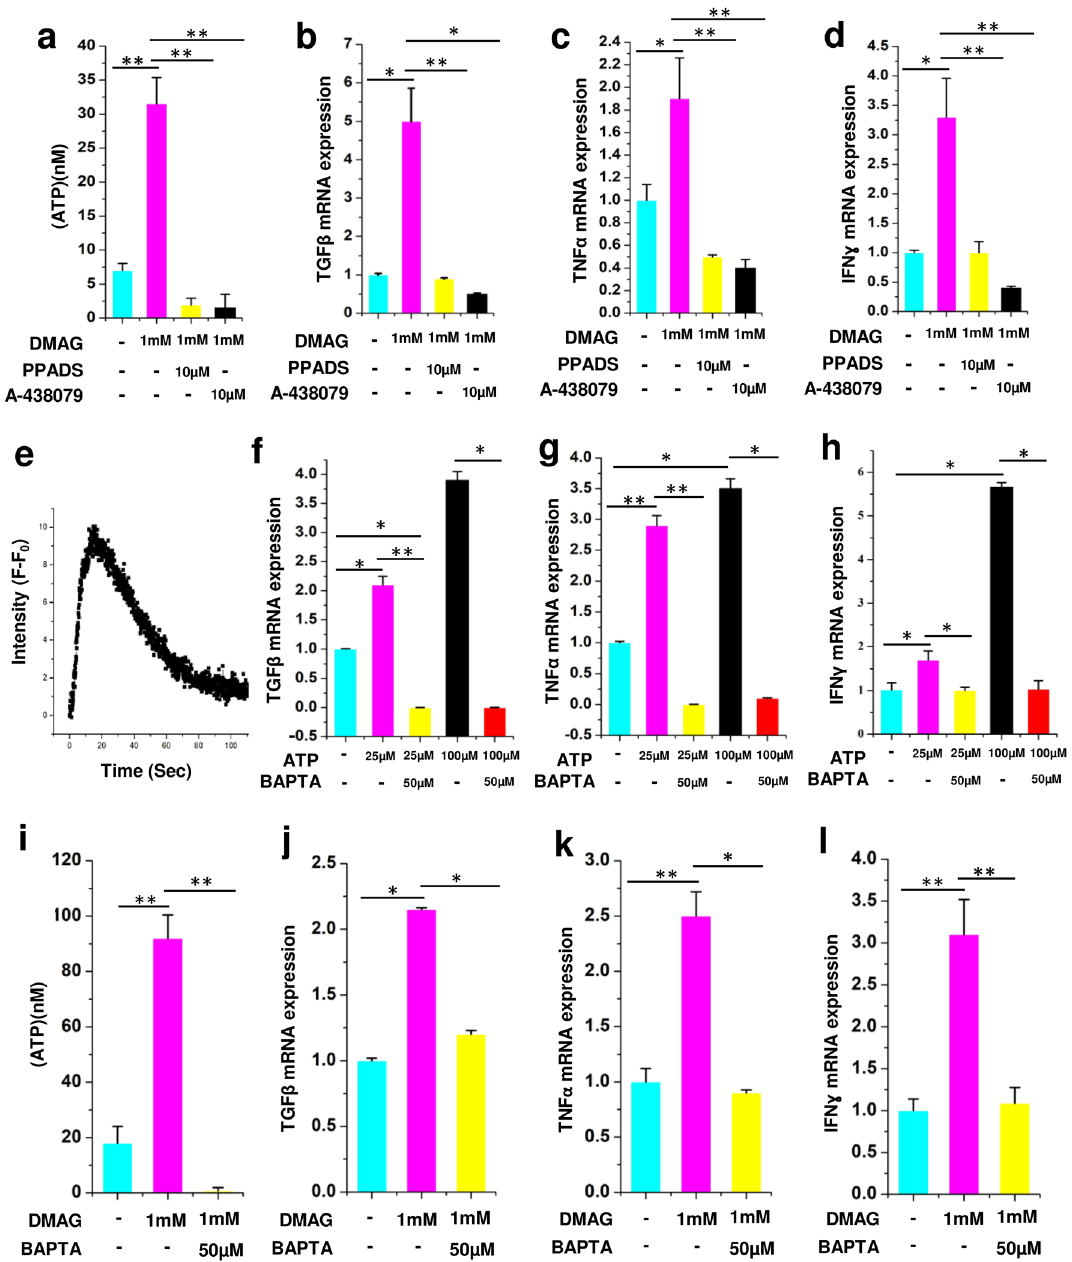
Figure 4. Showing DMAG induced ATP secretion and expression of cytokines as well as their modulation by P2 receptor inhibitors and calcium chelator, ATP induced calcium response, cytokine expression, modulation by calcium chelator, ( a – d ) DMAG treated N9 cells with or without pre-incubation with PPADS (10 μM) or A-438079 (10 μM) showing ( a ) treated with DMAG inducing the secretion of ATP which is inhibited by PPADS or A-438079. ( b ) TGFβ ( c ) TNFα ( d ) IFN ɣ . Showing ATP (100 μM) treated N9 cells ( e ) Elevated intracellular calcium time in seconds along X-Axis and Intensity (F − F 0 ) which is base line fluorescence subtracted from observed fluorescence along Y axis. Expression of cytokines by N9 microglial cells treated with ATP (25 μM or 100 μM) in the presence or absence of BAPTA (50 μM) showing ( f ) TGFβ ( g ) TNFα ( h ) IFNγ. DMAG (1 mM) treated N9 cells with or without pre-incubation with BAPTA (50 μM), showing ( i ) secretion of ATP and inhibition by BAPTA. ( j ) TGFβ ( k ) TNFα ( l ) IFN ɣ . The significance was calculated using Student T- test. *for P < 0.05, ** for P < 0.01, and *** for P < 0.001. For n numbers and the results provided as mean ± SEM, refer to